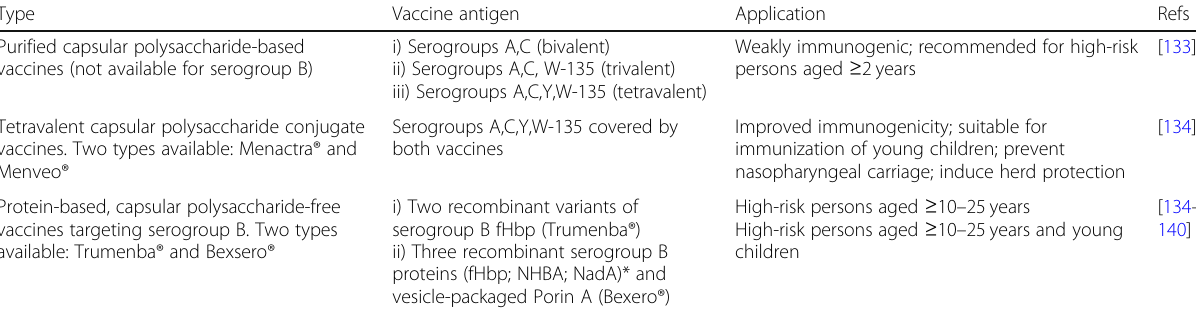
Table 2 Types and applications of meningococcal vaccines Type Vaccine